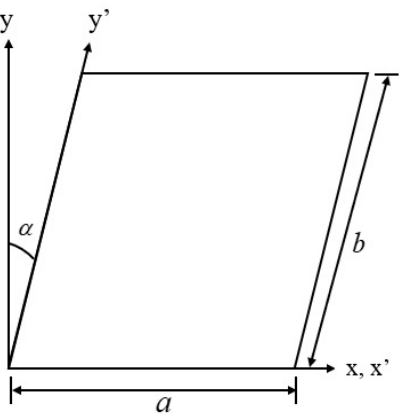
Figure 2. The coordinate system of the rhombic plate.